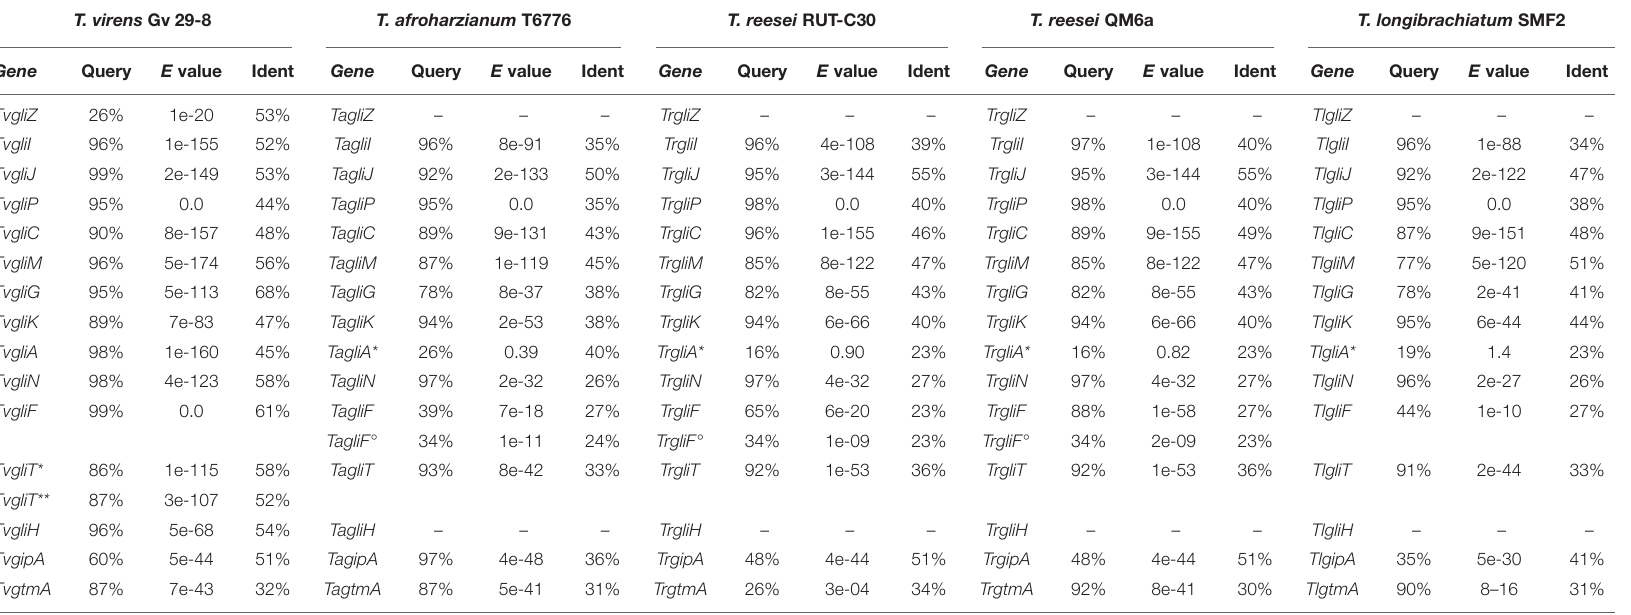
TABLE 2 | Sequence similarity analyses of the gli gene orthologs in T. virens , T. afroharzianum , T. reesei , and T. longibrachiatum